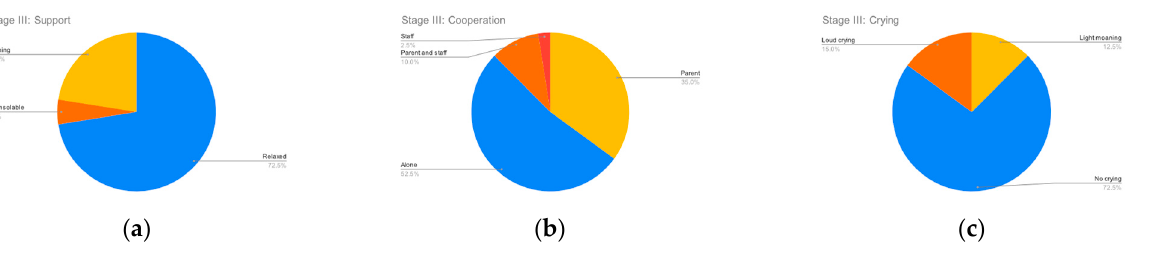
Figure 4. Stage III parameters. ( a ) Support; ( b ) Cooperation; ( c ) Crying.